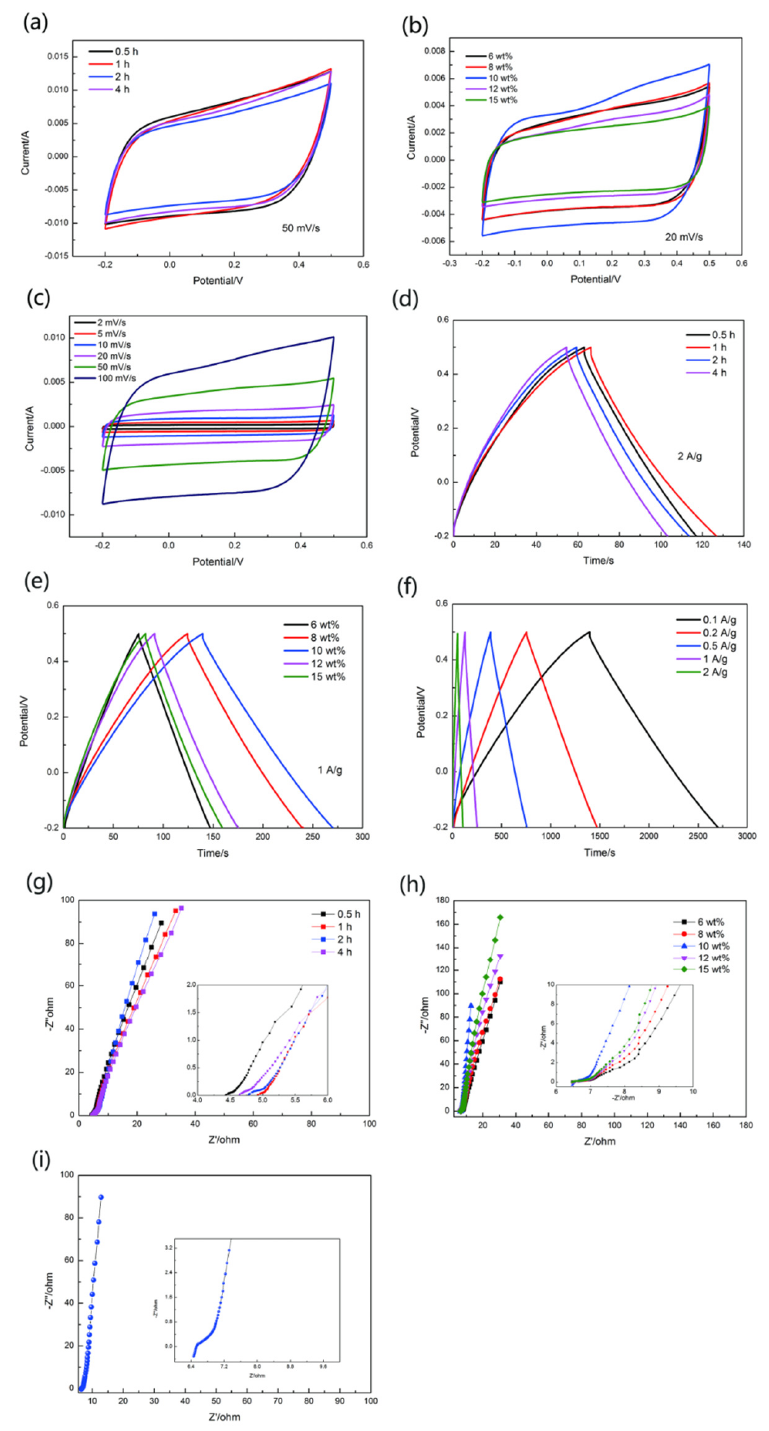
Figure 5. Electrochemical performance of yarn-shaped electrodes. ( a ) CV curves, ( d ) GCD curves, and ( g ) Nyquist plots of the CFs@10 wt%-PAN NFs@PPy with di ff erent desposited time by 0.5 h, 1 h, 2 h, 4 h. ( b ) CV curves, ( e ) GCD curves, and ( h ) Nyquistplots of CFs@PAN NFs@1 h-PPy with di ff erent concentrations(6 wt%, 8 wt%, 10 wt%, 12 wt% and 15 wt%). ( c ) CV curves, ( f ) GCD cvrves, and ( i ) Nyquistplots of CFs@10 wt%-PAN NFs@1